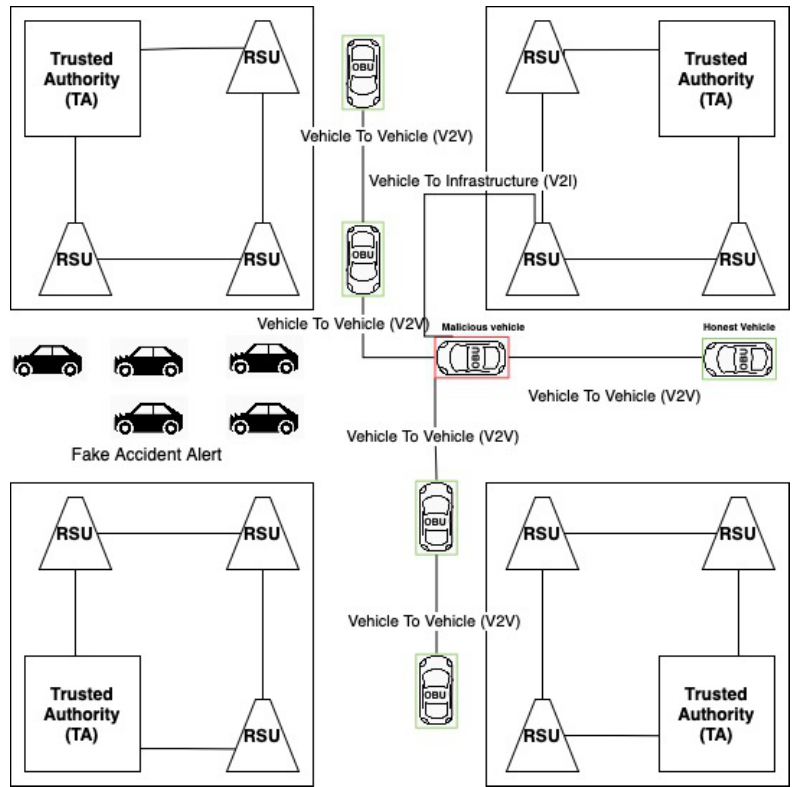
Figure 2. Example of bogus information